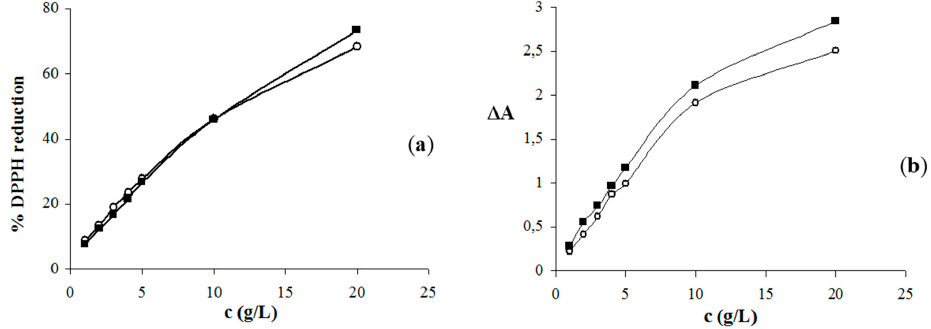
Figure 1. The antiradical activity ( a ) and reducing potential ( b ) of S. subspicata Vis. honey